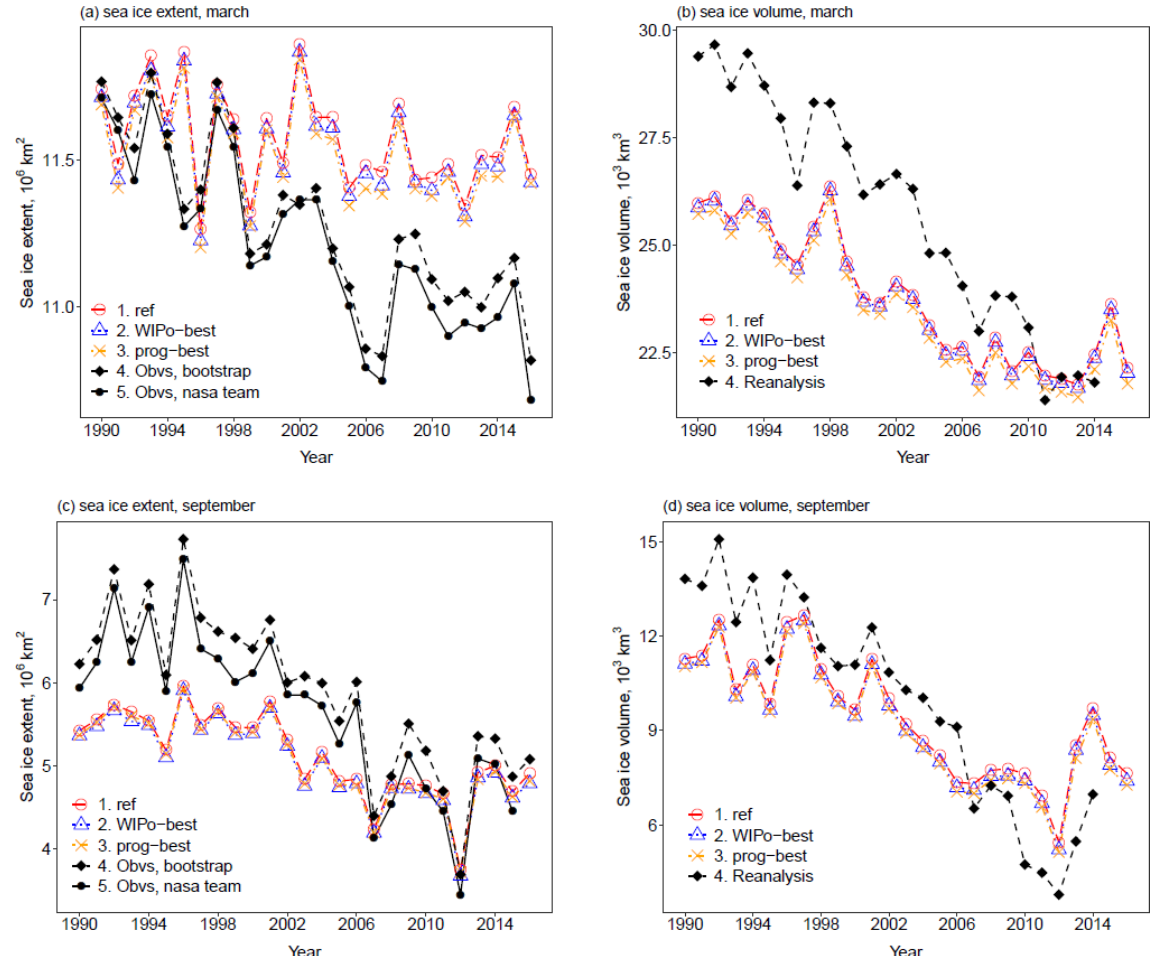
Figure 5. The total March extent (a) , March volume (b) , September extent (c) , and September volume (d) for Arctic sea ice within the model domain over the period 1990–2016 for ref (red, circles), WIPo-best (blue, triangles), prog-best (yellow, cross), and observations/reanalysis (black). Sea ice concentration data are obtained from satellites using the Bootstrap (filled diamond, dashed) algorithm version 3 (Comiso, 1999) and the NASA Team (filled circle, solid) algorithm version 1 (Cavalieri et al., 1996). Sea ice volume data (filled diamond, dashed) are taken from PIOMAS (Zhang and Rothrock,